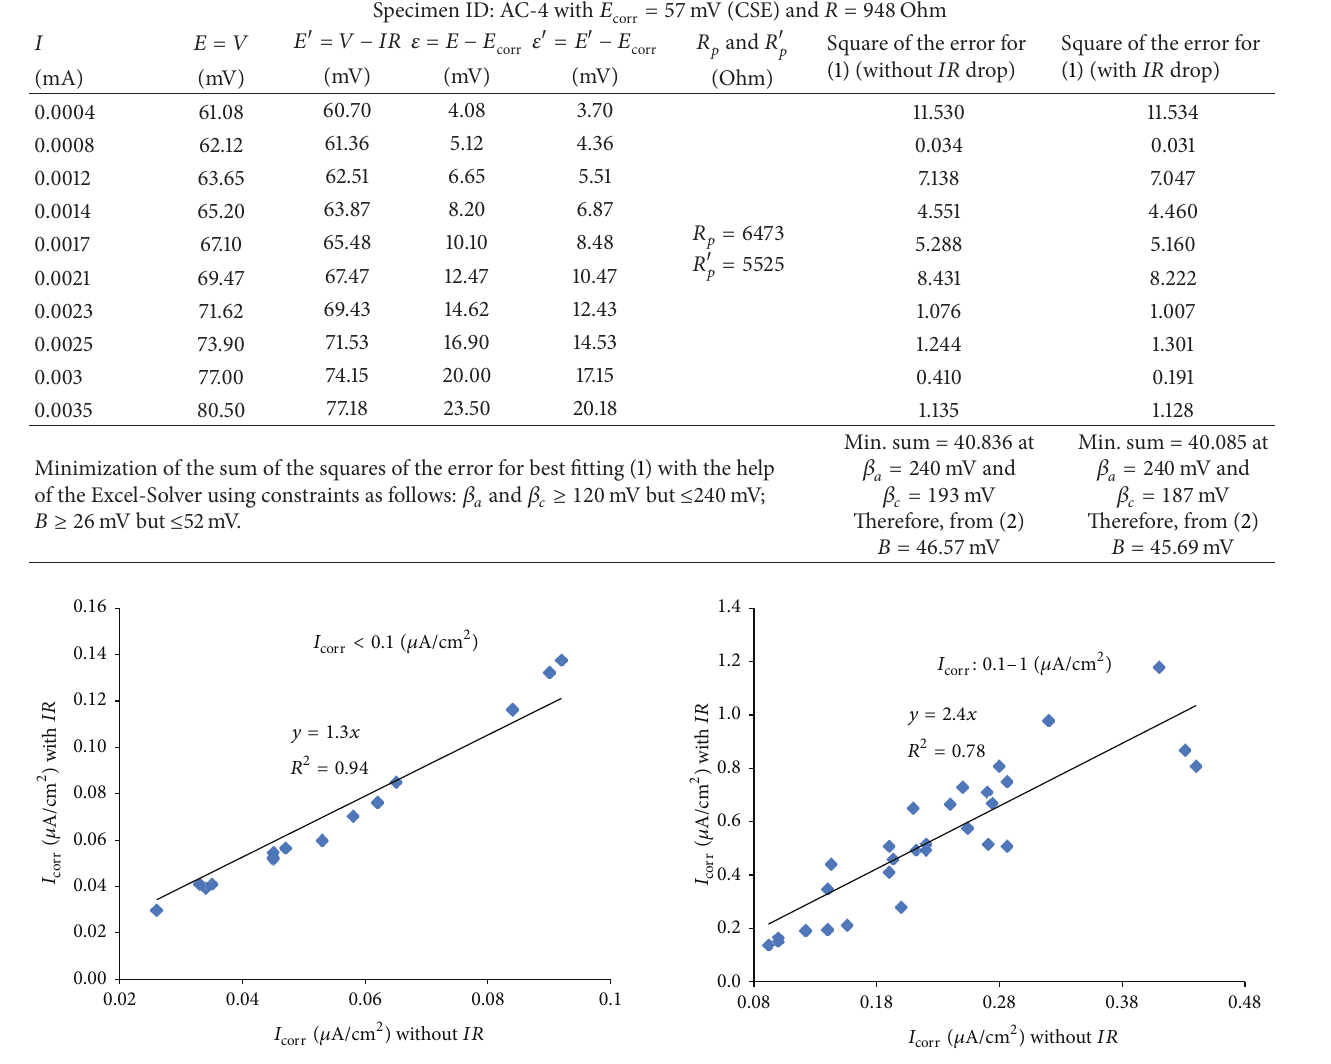
with and without 𝐼𝑅 compen- corr